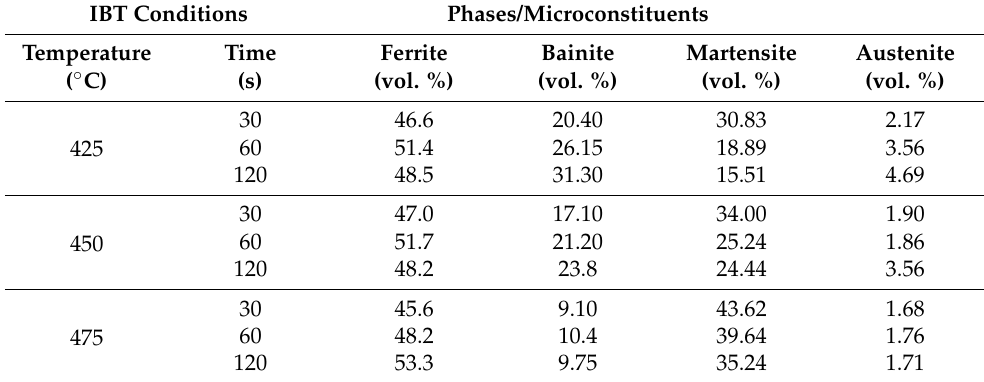
Figure 12. Experimental IQ-maps and normalized IQ values of samples subjected to 120 s of IBT at temperturatures of: ( a , b ) 425 °C, ( c , d ) 450 °C and ( e , f ) 475 °C. Table 2. Percentage of phases and microconstituents as a function of IBT time/temperature (vol.